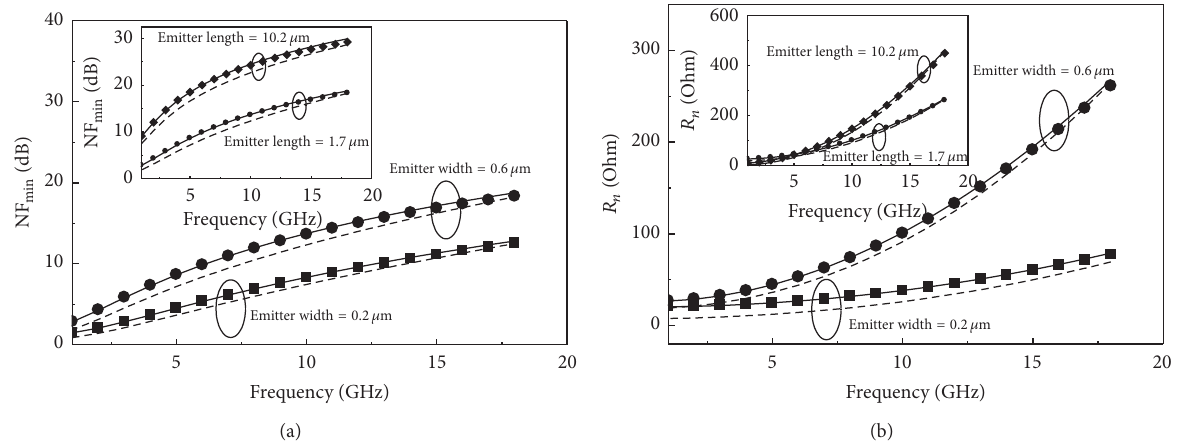
Figure 2: Measured (symbols) and simulated (lines) minimum noise figure and equivalent noise resistance at 𝑉 BE = 1.1V and 𝑉 CE = 3.6 V in the breakdown region for different emitter widths. The emitter length is fixed as 1.7 𝜇 m. Solid and dash lines depict the results obtained from the noise model with and without considering the breakdown network, respectively. In the inset, the results for different emitter lengths as the emitter width is fixed as 0.6 𝜇 m are shown. (a) Minimum noise figure. (b) Equivalent noise resistance.